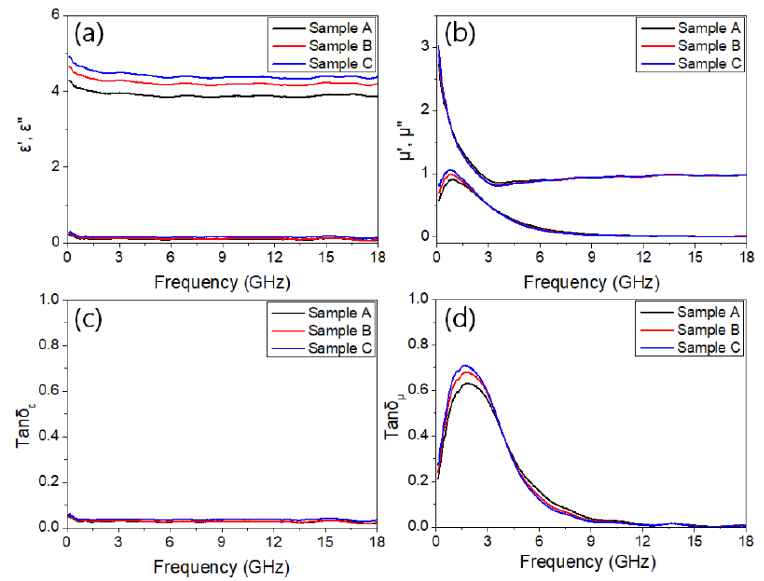
Figure 5. EM properties of NZN composite samples: ( a ) real and imaginary permittivity, ( b ) real and imaginary permeability, ( c ) electric loss tangent, and ( d ) magnetic loss tangent. Table 3. The Composition of Sample A, B, and